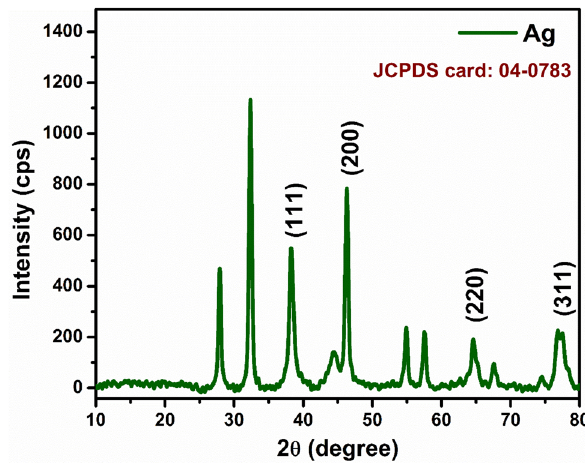
Figure 5: XRD pattern of Z. mays silk - fabricated